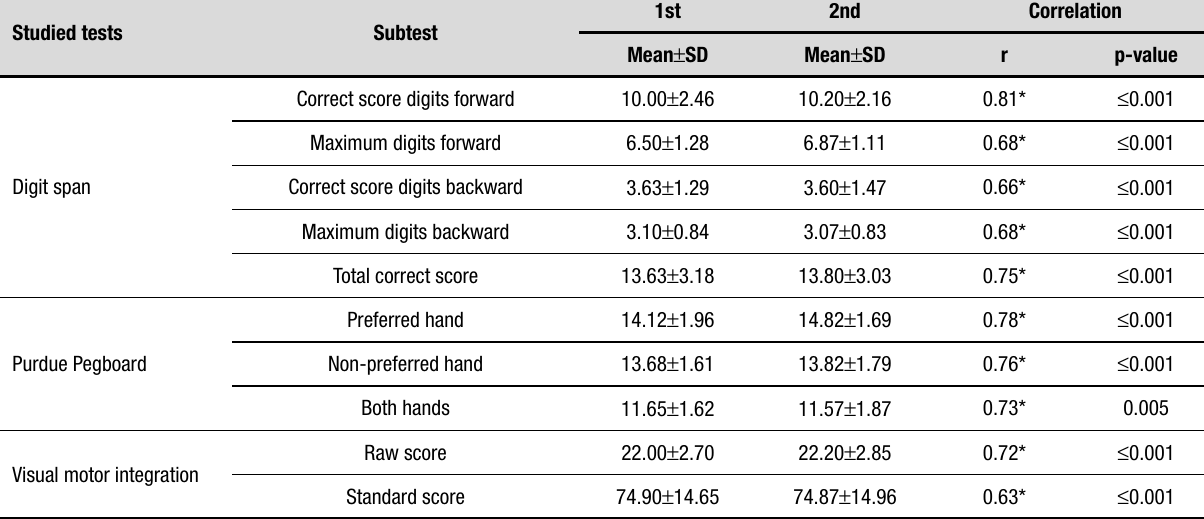
Table 2. Test-retest reliability of digit span, Purdue Pegboard, and visual motor integration tests (n=30).